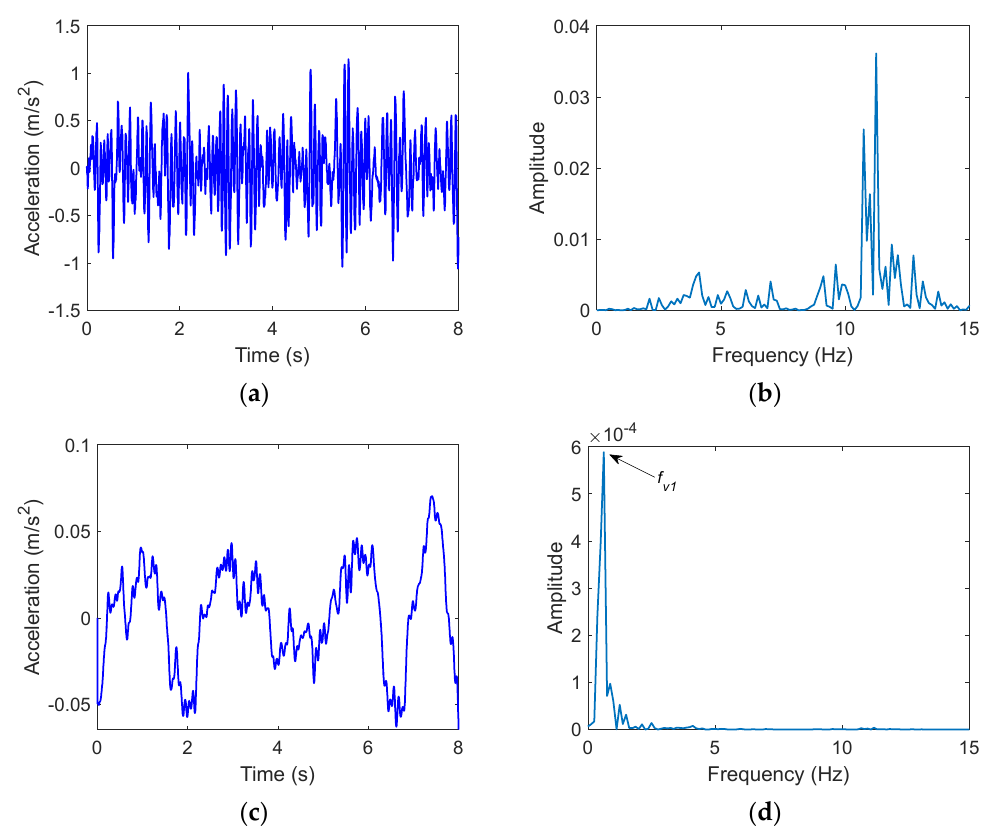
.. u a ; .. .. u s ; ( d ) spectrum for u s